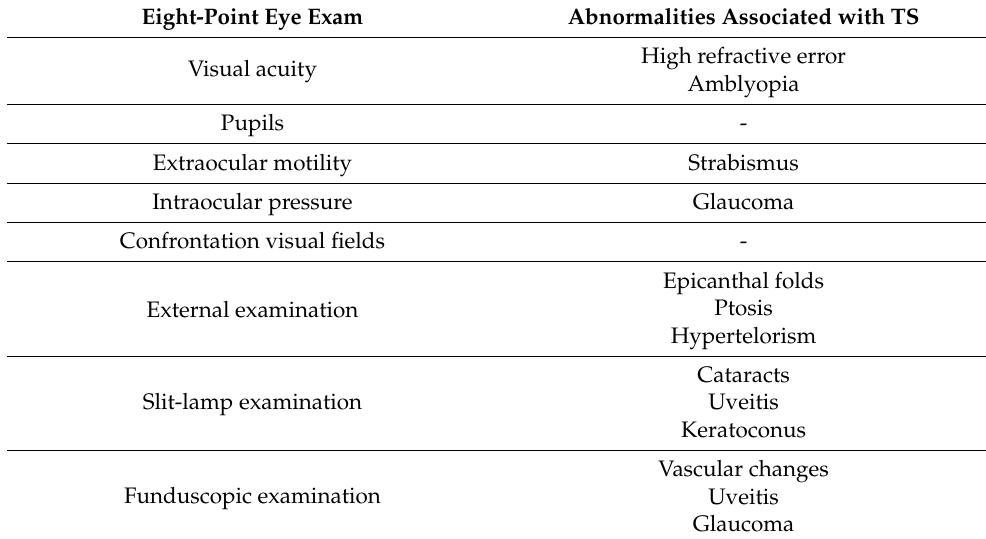
Table 1. Ocular abnormalities associated with Turner Syndrome (TS) as part of the eight-point eye exam